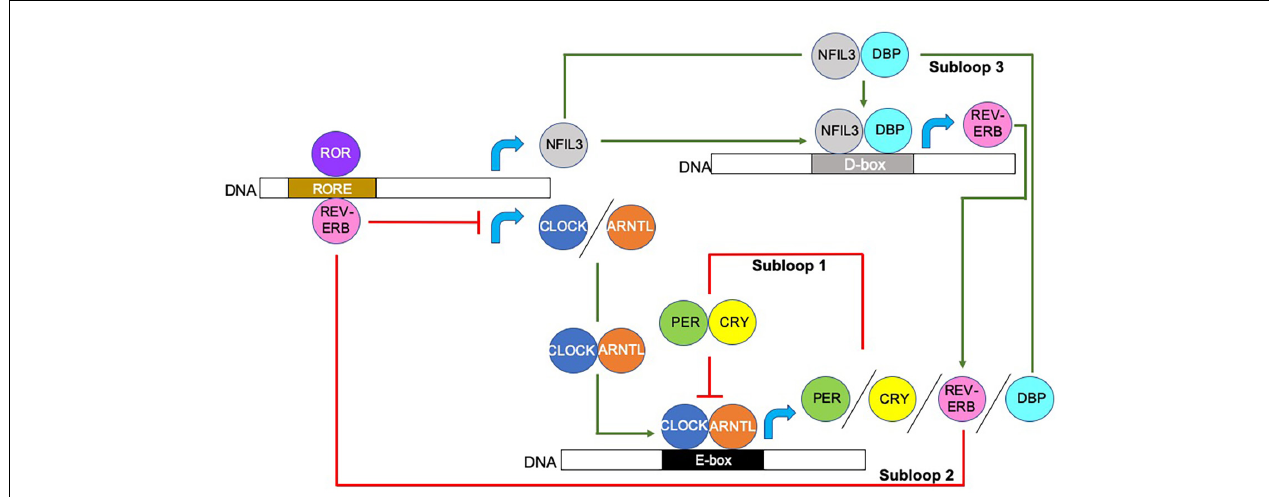
FIGURE 1 | Molecular modulation of circadian rhythm. Circadian rhythms are initiated and regulated by transcriptional/translational feedback loops. Circadian locomotor output cycles kaput (CLOCK) and Aryl hydrocarbon receptor nuclear translocator like (ARNTL; also known as BMAL1) proteins heterodimerize and bind to the E-box motifs of Period ( Per ) and Cryptochrome ( Cry ) genes, driving their transcription (Gekakis et al., 1998; Yoo et al., 2005; Xu et al., 2015). When PER and CRY protein concentrations increase, they too form heterodimers and counter-regulate the CLOCK/ARNTL complex, and thus, inhibit their own expression. CLOCK/ARNTL heterodimer proteins also drive the expression of the nuclear receptors REV-ERB α (encoded by Nr1d1; known as nuclear receptor subfamily group D member (Nr1d) 1) and REV-ERB β (encoded by Nr1d2 ) (as shown by REV-ERB), which bind to retinoic acid-related orphan binding elements (ROREs) located in the CLOCK and ARNTL promoters, repressing Clock/Arntl transcription. A third subloop driven by the CLOCK/ARNTL complex, involves the proline and acidic amino acid-rich basic leucine zipper factors, D-box binding protein (DBP), thyrotroph embryonic factor and hepatic leukemia factor proteins (represented as DBP in the figure) (Takahashi, 2017). These proteins interact with the transcriptional repressor Nuclear Factor, Interleukin 3 Regulated (NFIL3; also known as E4BP4), the expression of which is driven by the REV-ERB/ROR loop, at sites containing D-boxes (Takahashi, 2017; Xie et al., 2019). Red lines indicate repression, green arrows indicate activation, blue curved arrows indicate gene transcription. Additional abbreviations used include deoxyribonucleic acid (DNA), Enhancer box (E-box) Destruction box (D-box), retinoic acid-related orphan receptor (ROR).